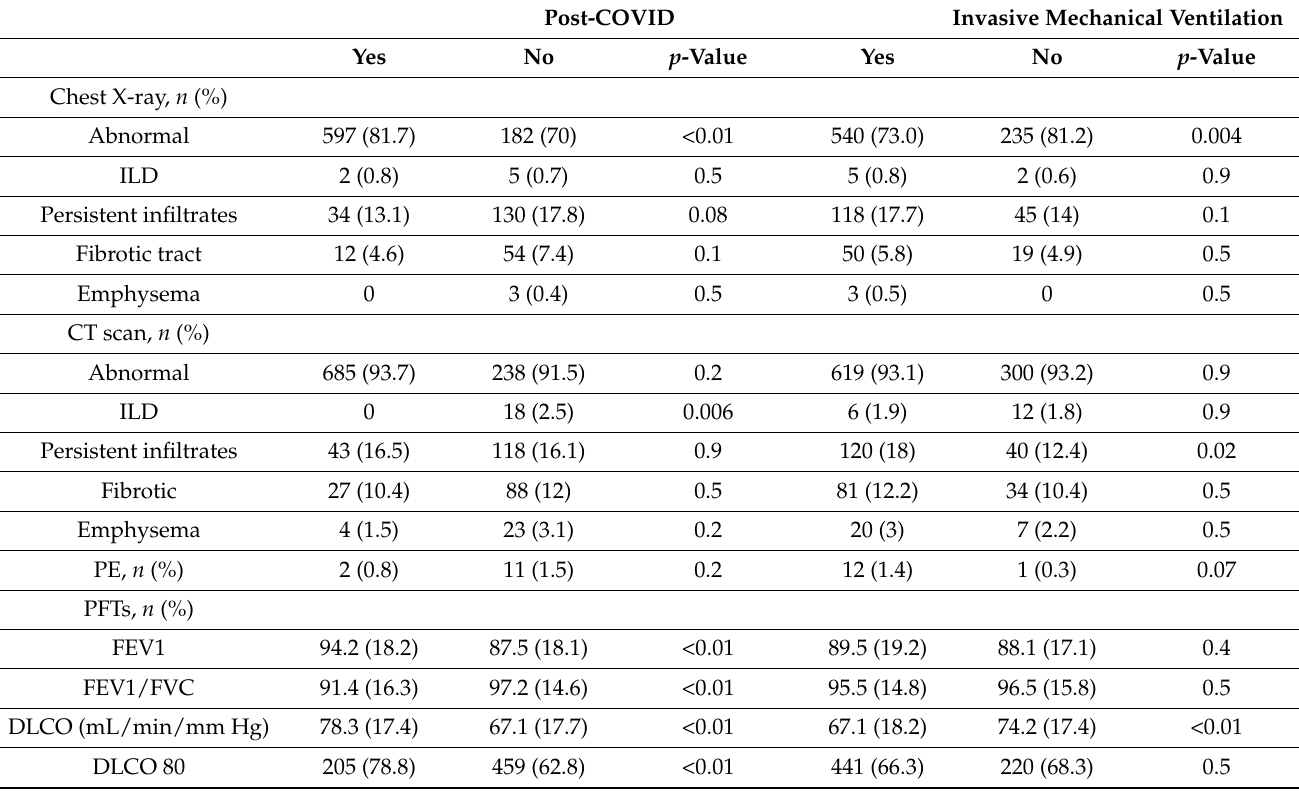
Table 2. Chest imaging and lung function tests in patients with persistent post-COVID-19 symptoms and in those who underwent invasive mechanical ventilation at 3-month